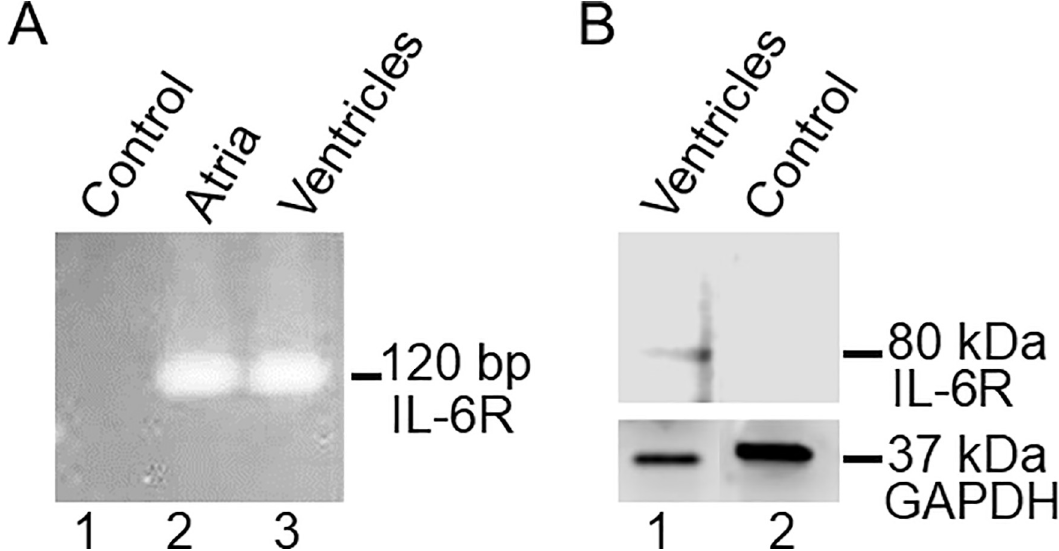
Fig 6. Transcript and protein expression of IL-6R in guinea pig heart. A , qRT-PCR assay for detection of IL-6R mRNA expression in guinea-pig heart. Compared to control ( Lane 1 ), IL-6R (120 bp) mRNA expression was detected in both atria ( Lane 2 ) and ventricles ( Lane 3 ) consistent with an endogenous IL-6R expression in guinea pig heart. B , Western blot of IL-6R from guinea-pig ventricular cell lysates. The blot was probed with anti-IL6R α H-7. The band around 80 kDa ( Fig 6B , Lane 1 ) represents IL-6R α which was absent when IL-6R α Ab was pre-incubated with its own blocking peptide ( Fig 6B , Lane 2 ).